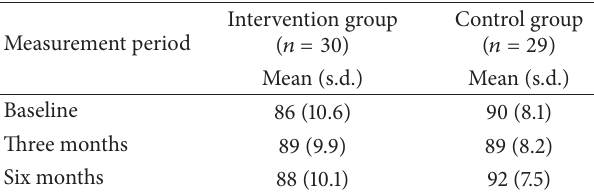
Table 3: Psychological well-being at baseline and three and six months in relation to a 10-week physical activity intervention.